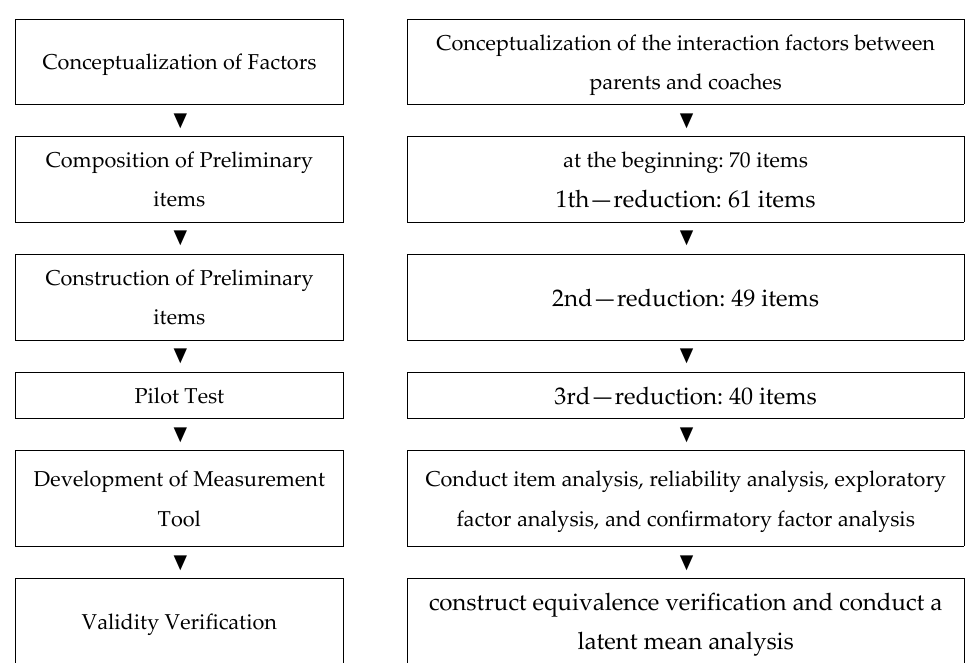
Figure 1. Procedure for developing a parent–coach interaction measurement